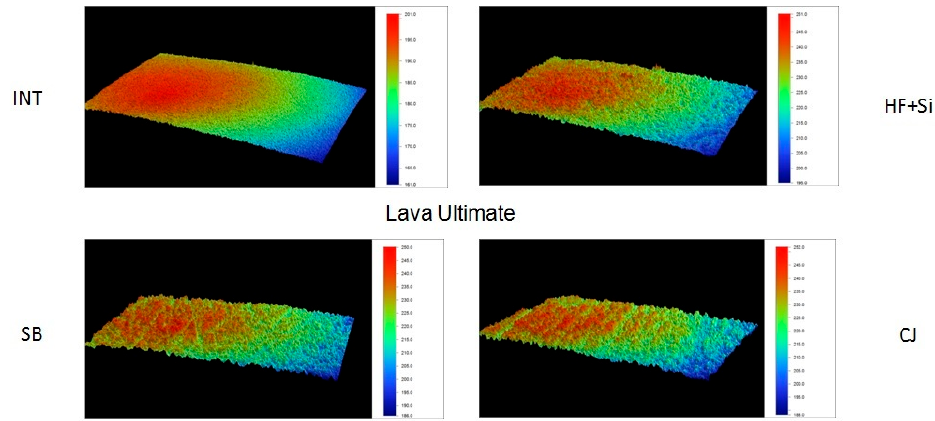
Figure 4. Representative 3D topographic surface maps of Lava Ultimate (×20 magnification).